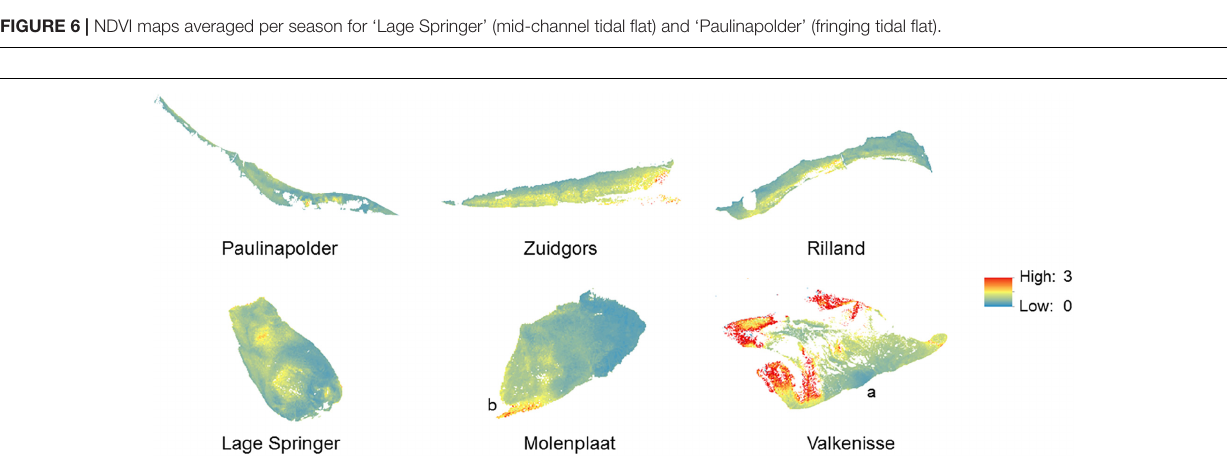
FIGURE 7 | Coefficient of variation of the NDVI (2016–2019). The coefficient of variation ranged from –5176 to